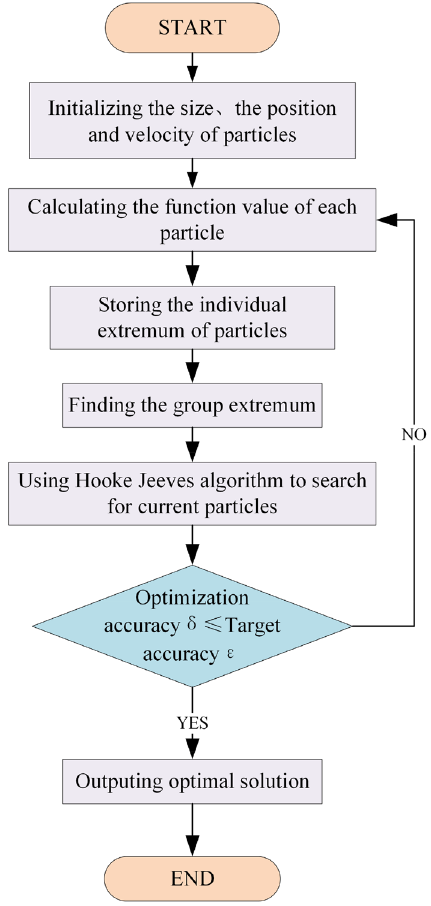
Figure 7. Optimization step diagram of improved particle swarm algorithm based on Hooke-Jeeves algorithm.